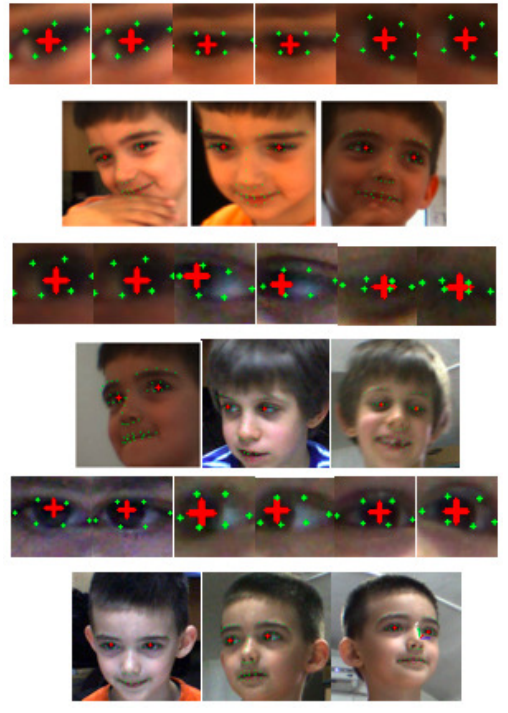
Figure 5: Images obtained from the intervention table localising the iris centres of the child.